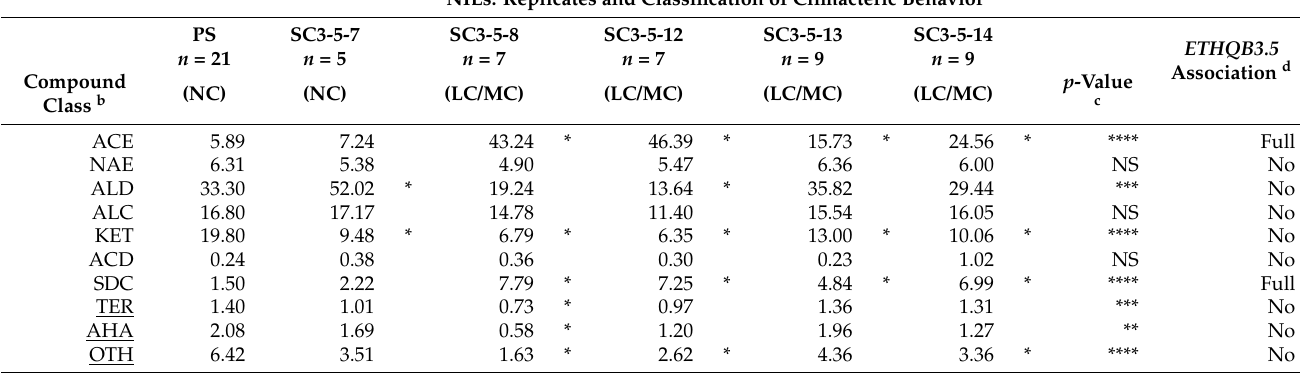
Table 1. Main compound classes identified for QTL mapping in melon chromosome 3 using five Near-Isogenic Lines (NILs) with different physiological behavior. Data are expressed as percentages of each compound class with respect to the total normalized